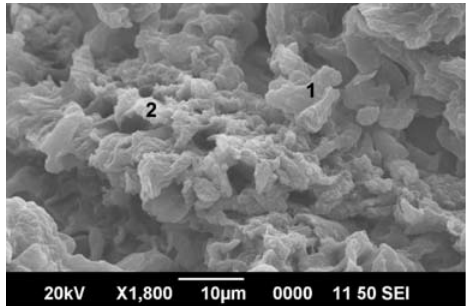
Fig. 4. sEm image of mucosal folds of the oviduct. sEm x 1800